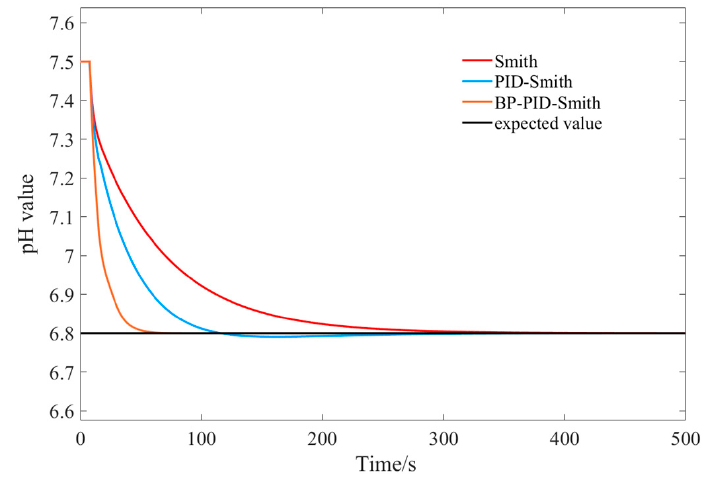
Figure 11. Step response curves of the three controllers under model matching.